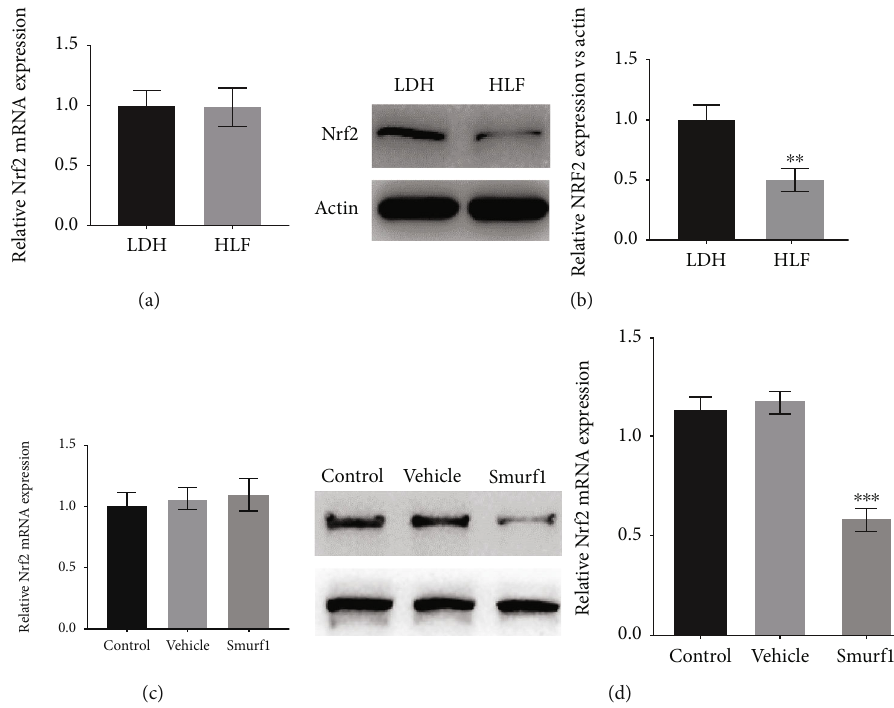
Figure 5: Nrf2 is the target of Smurf1. (a) Nrf2 mRNA level in the LDH and HLF patients was assessed by qRT-PCR ( n = 27 ). (b) Western blotting and semiquanti fi cation for Nrf2 level in the LDH and HLF patients ( n = 10 ). ∗∗ p < 0 : 01 . (c) qRT-PCR was used to determine the level of Nrf2 mRNA in LF cells with or without Smuf1-OE. (d) Western blotting and semiquanti fi cation for Collagen I, Collagen III, and α -SMA mRNA level in the LF cells with or without Smuf1-OE. ∗∗∗ p < 0 : 001